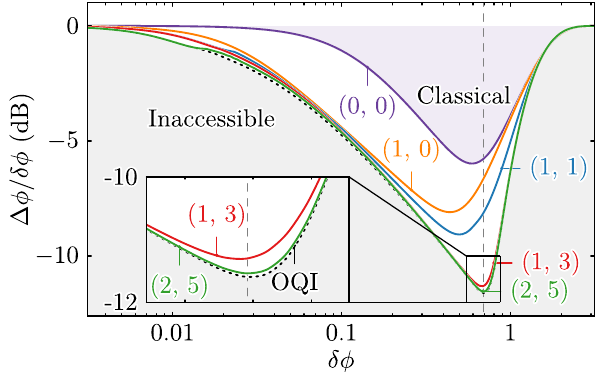
FIG. 2. Performance of the variationally enhanced interfer- ometer with N ¼ 64 particles. Performance is shown in terms of the posterior phase distribution width relative to the prior width, Δ ϕ = δϕ , for a given prior, that is, for a given dynamic range of the interferometer. Colored lines show the performance of variationally optimized circuits for the depth ð n entangling and decoding layers as indicated. The number of variational parameters is given by 3 ð n mance of the optimal quantum interferometer (OQI) [31] is indicated by the dotted line. The shaded areas indicate the classically accessible (purple) and the quantum mechanically forbidden (gray) regions (for N ¼ 64 ). Related results applied to atomic clocks are shown in Fig.